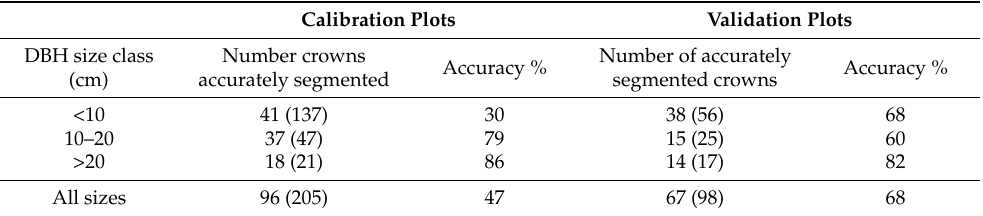
Table 1. Segmentation accuracy results for the different DBH size classes of manually segmented tree crowns. Numbers in brackets represent the total number of manually segmented crowns per size